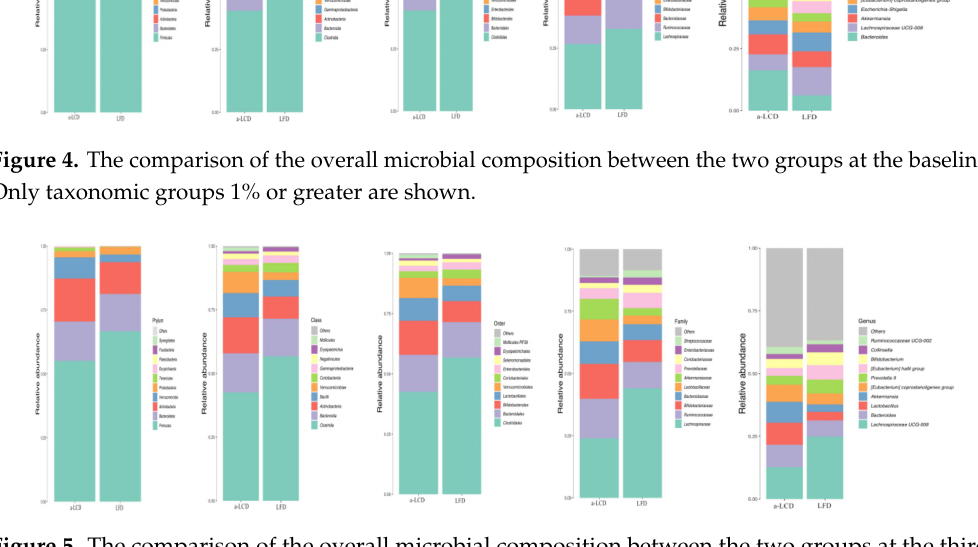
Figure 5. The comparison of the overall microbial composition between the two groups at the third month. Only taxonomic groups 1% or greater are